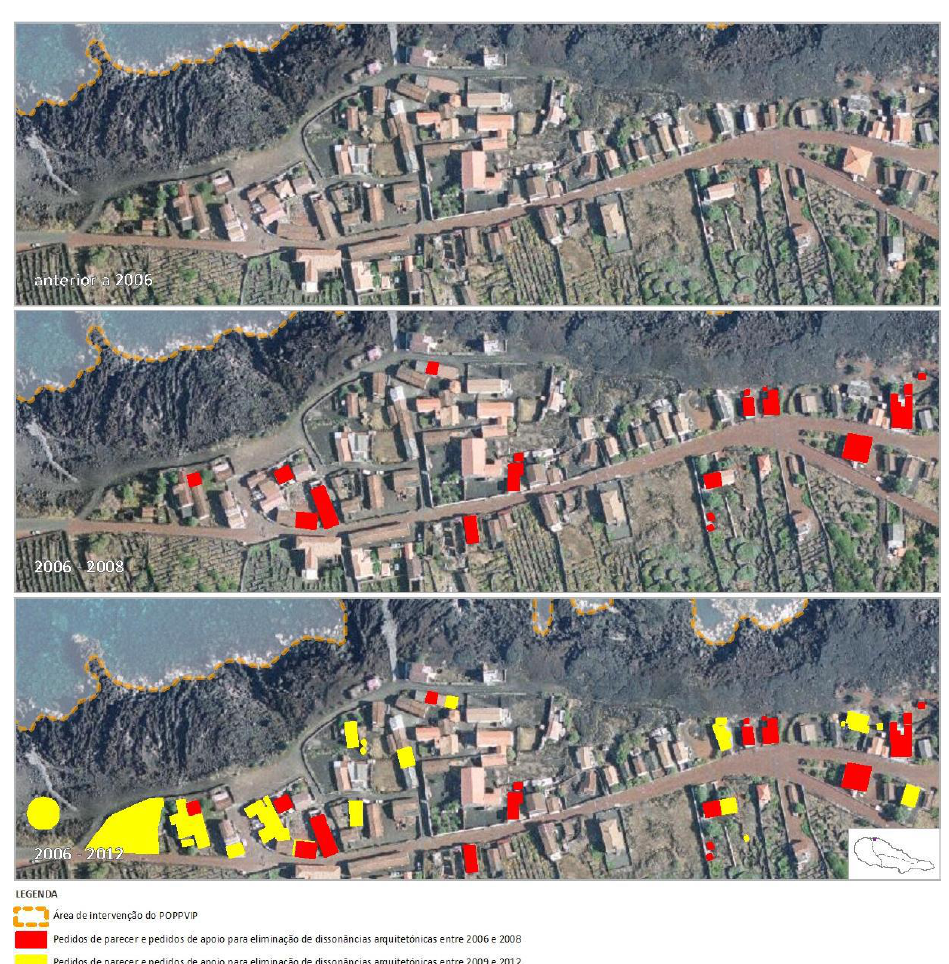
Figure 8. Processes for architectonic dissonances correction between 2006 and 2012 in Lajido. Source: Rocha